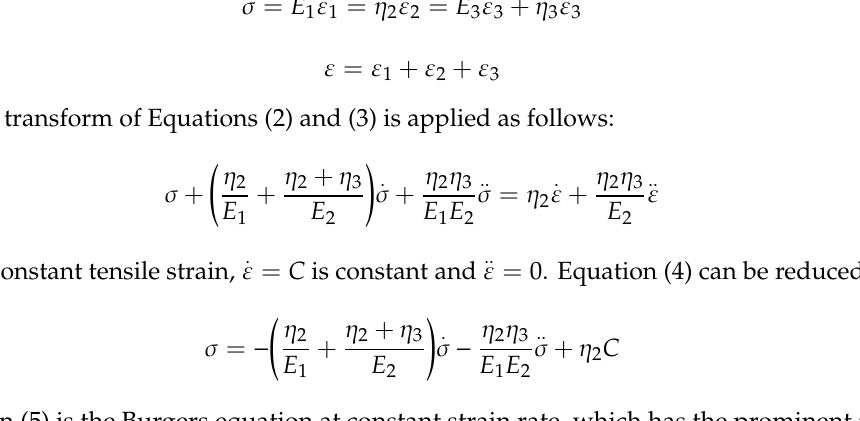
Figure 5. Burgers Figure 5. Burgers model.